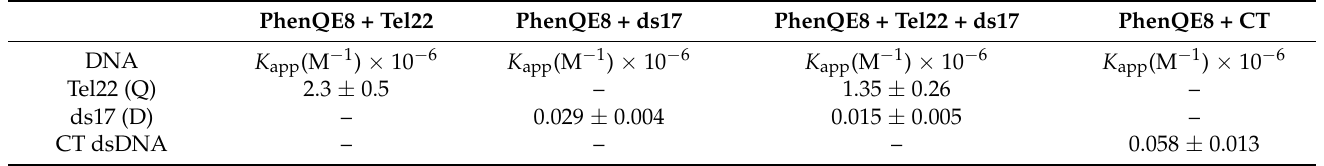
Table 1. Apparent association constants of PhenQE8 with quadruplex DNA Tel22 and with ds DNA (ds17 and CT DNA) obtained by noncompetition and competition equilibrium dialysis in ionic potassium conditions (10 mM potassium phosphate buffer, 100 mM KCl, pH =